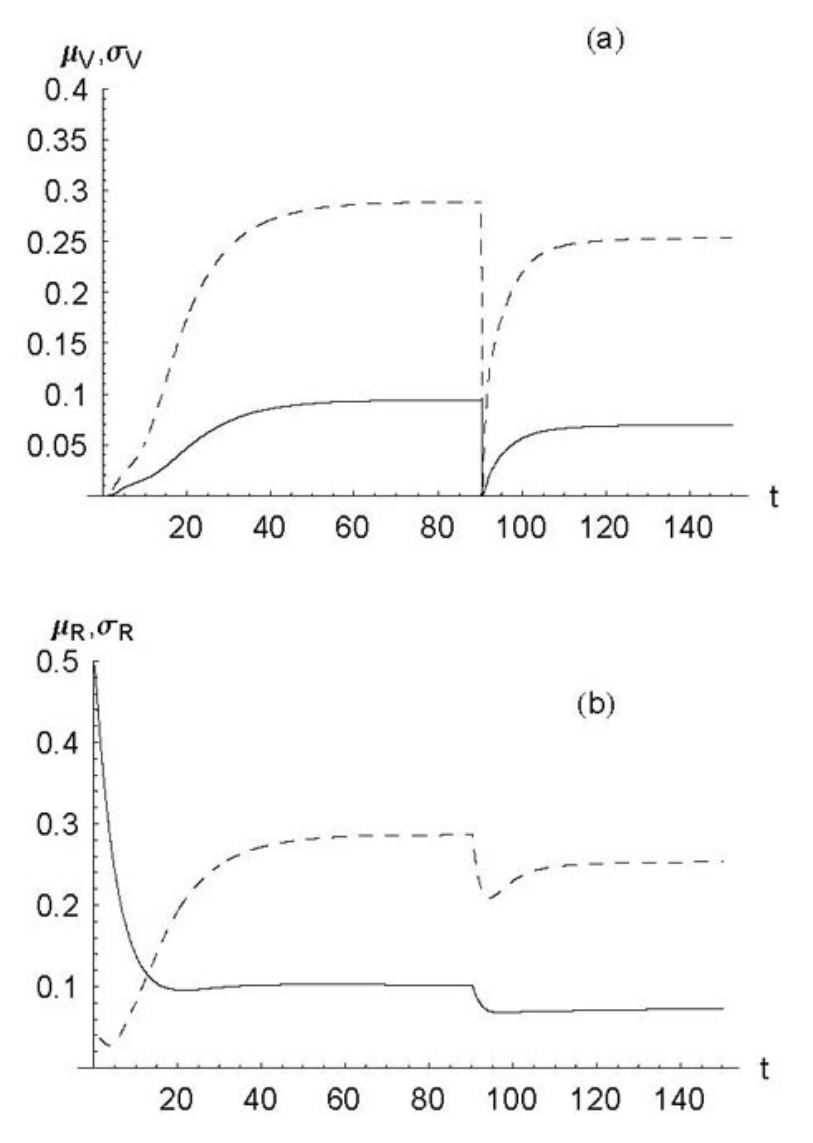
Fig. 4. Model-simulated temporal evolution of the spatial means ( m s ) of the fields of V and R using the same parameters as in Fig. 2a. The removal of shrub vegetation at R time t ' = 250 is followed by a period of resource depletion concurrent to the establishment, growth, and encroachment of new shrub seedlings, and by a period of resource accumulation due to autogenic mechanisms induced by shrub vegetation. At a steady state, both shrub biomass and resources attain asymptotic levels lower (by about 43% in the case of V ) than those existing before time t ' = 250, whereas the asymptotic values of the coefficients of variation, s (not shown) obtained with the same parameters as in Fig. 2c lead to even lower post-disturbance steady- state values of V